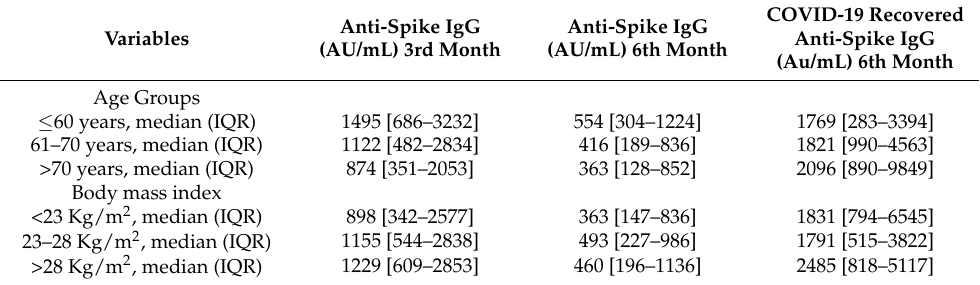
Table 3. Comparison of humoral immunity status in the three age and body mass index